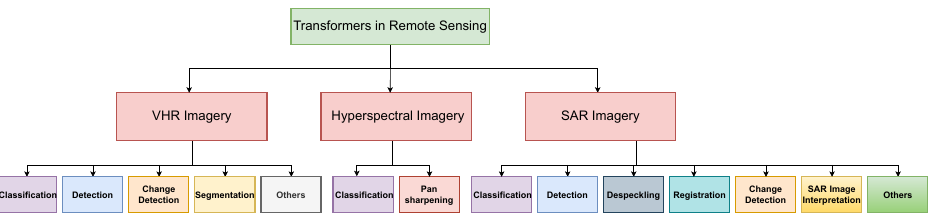
Figure 4. The taxonomy of transformers in VHR, hyperspectral and SAR imagery with a variety of tasks, such as classification, detection, segmentation, pan sharpening and change